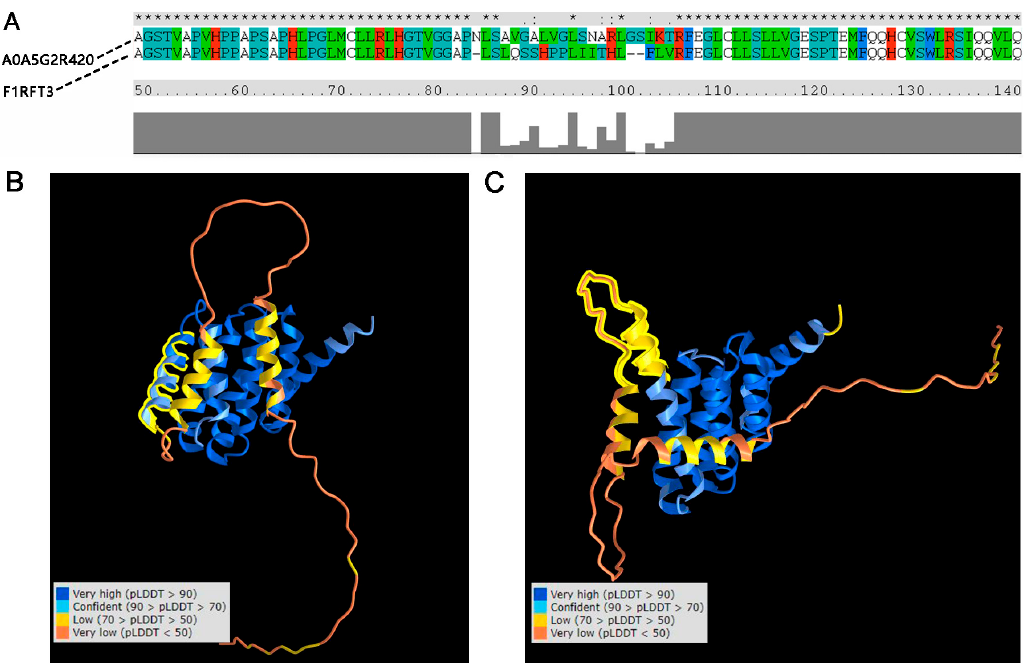
Figure 6. Comparison of the sequence and structure of PELP1 alternative-splice proteins. ( A ) Sequence alignment of the two proteins. A0A5G2R420: protein translated by ENSSSCT00000075280. F1RFT3: protein translated by ENSSSCT00000019507; ( B ) 3D structure of A0A5G2R420, where the structure marked by a yellow line indicates a helix with very high confidence (predicted LDDT (pLDDT) > 90); ( C ) 3D structure of F1RFT3, where the structure marked by a yellow line indicates an unfolded helix with low confidence (70 > pLDDT > 50).